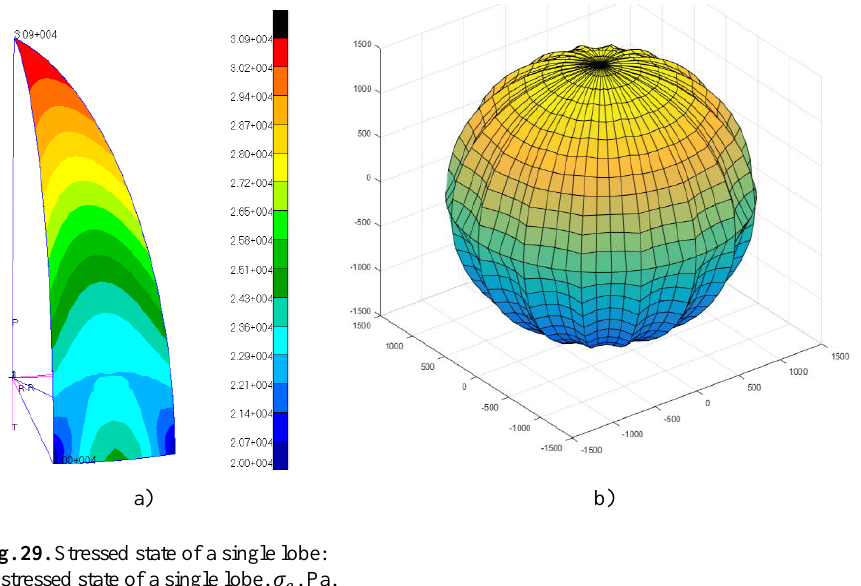
Fig. 29. Stressed state of a single lobe: а) stressed state of a single lobe, 𝜎 𝑒 , Pa, б) quasispherical shape of the reflector with diameter of 2 m plotted by experimental